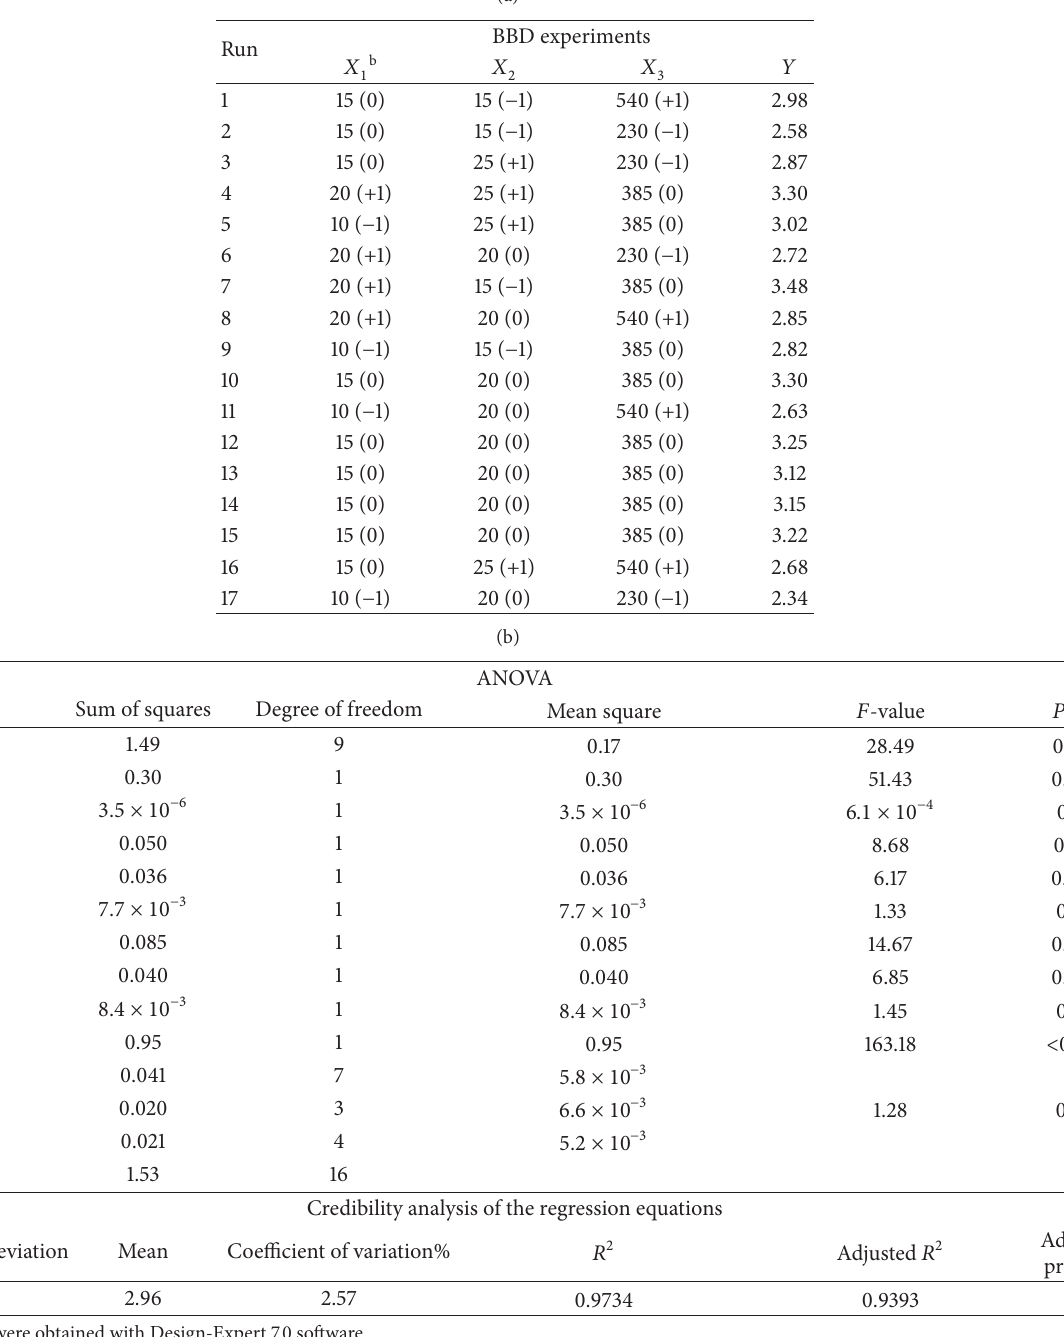
Table 1: Experimental design matrix to screen for variables that determine the yield of geniposidic acid and ANOVA results a